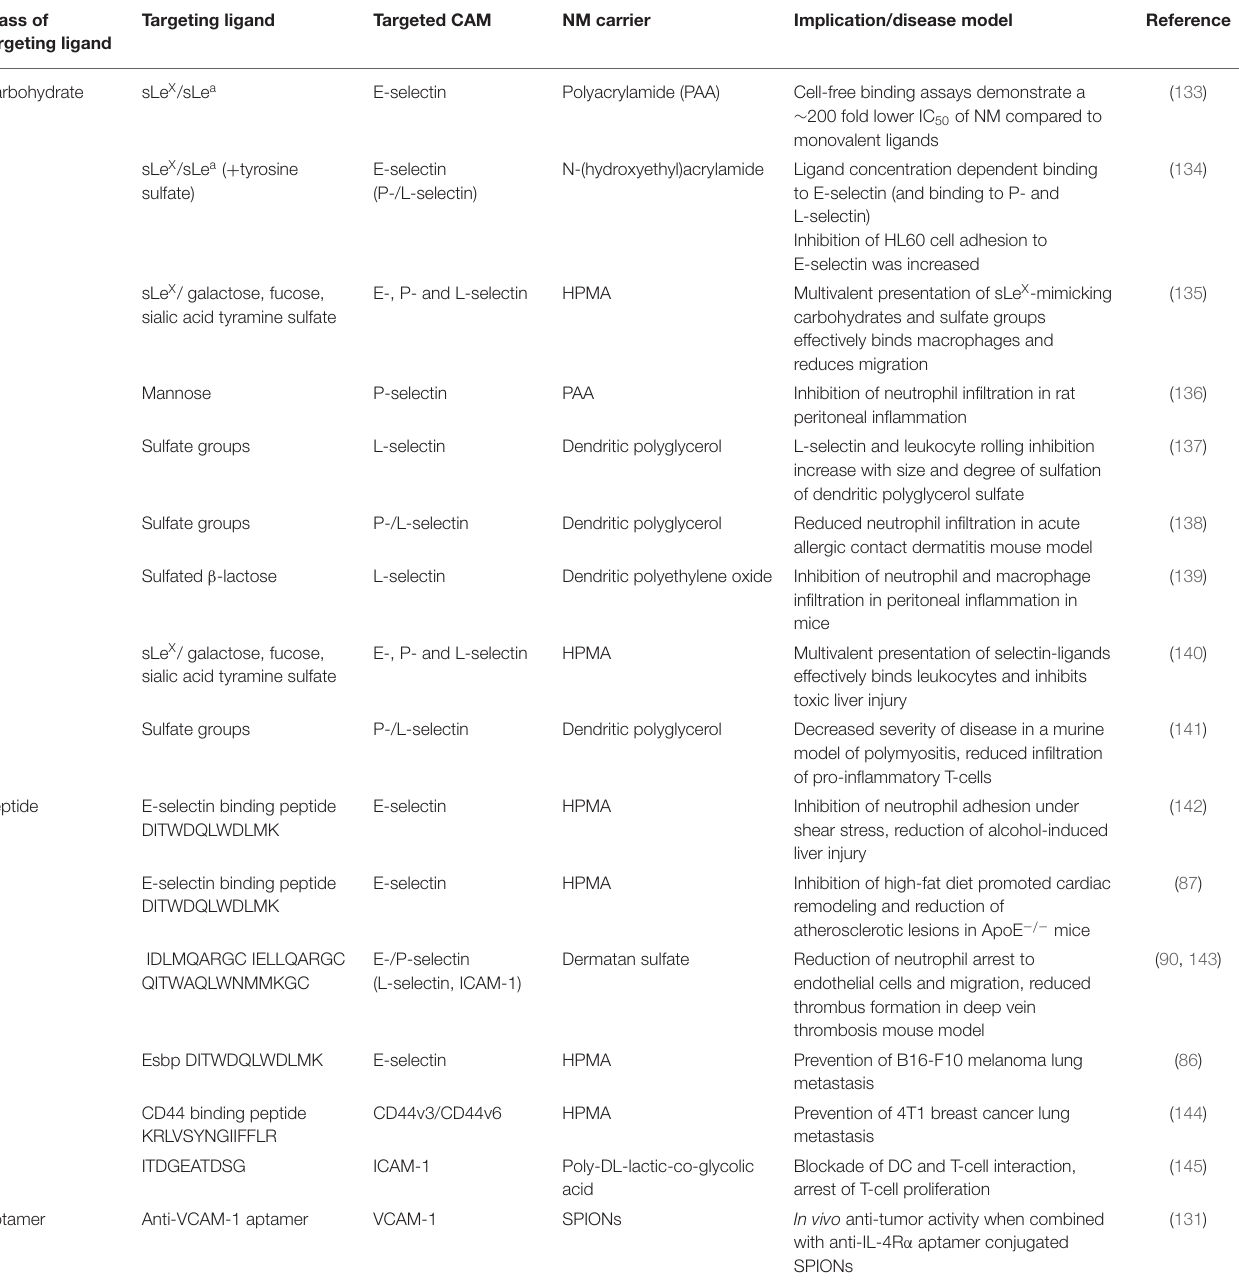
TABLE 4 | Selected examples of “drug-free” NM targeting